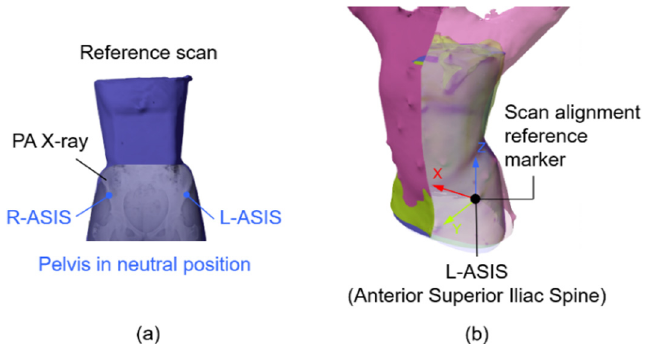
Figure 2. Alignment of the different scans obtained during the patient assessment and rectification process. ( a ) The post-rectification mould is used as the reference scan for alignment, oriented in a neutral pelvis position using the PA X-ray from the patient and the pelvis markers R-ASIS and L-ASIS located at the anterior superior iliac spine. ( b ) Isometric view of the three scans (patient’s body, pre-, and post-rectification mould) aligned using the L-ASIS marker as the orientation reference for a right curve